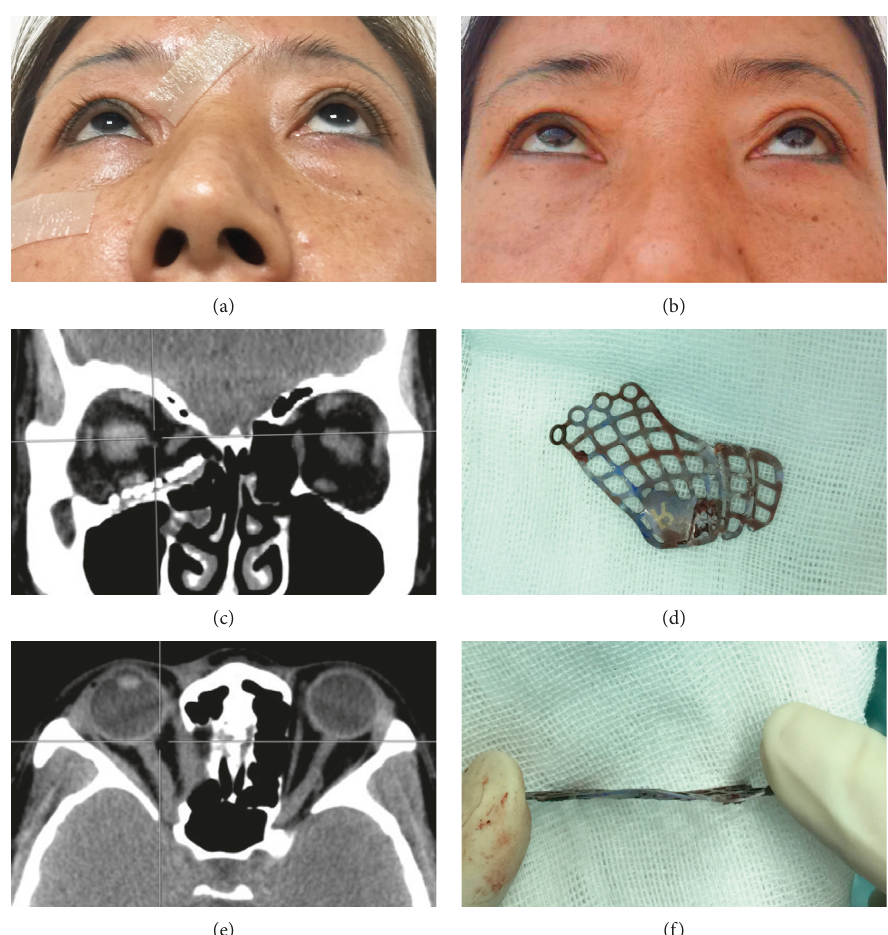
Figure 1: Case of a malpositioned titanium mesh implant. (a) Enophthalmos 1 month after previous orbital fracture repair. (b) The enophthalmos was fully corrected 6months after secondary implantation of RapidSorb. (c and e) CT images showing that the implant did not fully cover the medial wall defect, causing herniation of orbital contents into the ethmoid sinus. (d and f) The explanted titanium mesh was flat and did not conform to the orbital anatomical